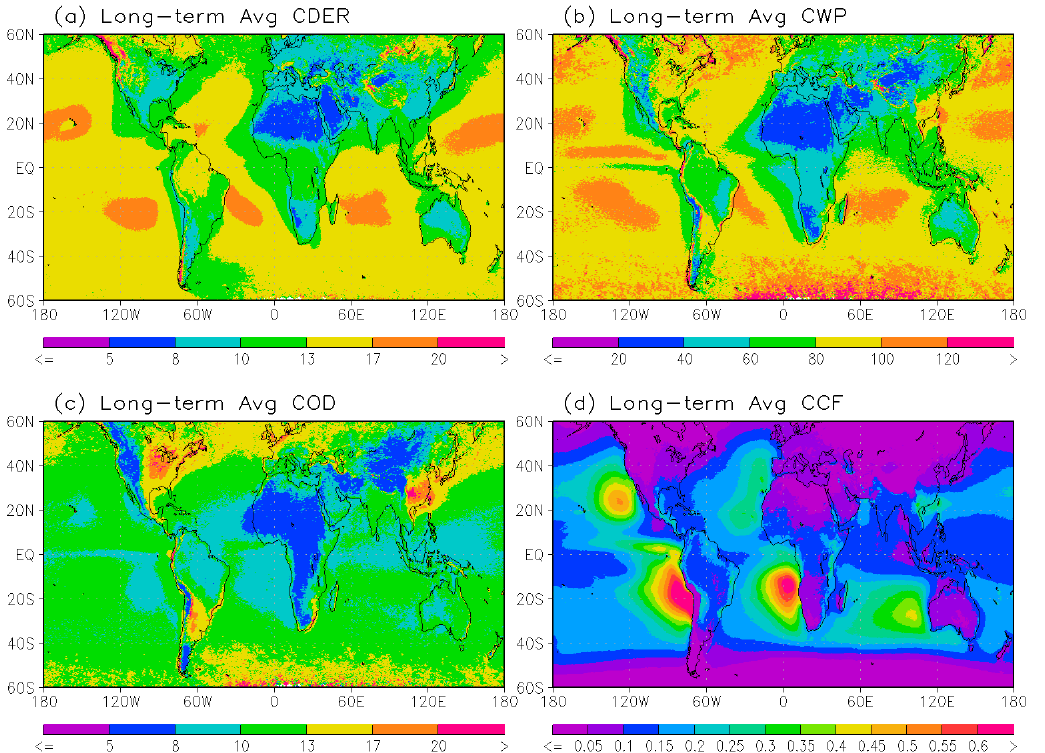
Figure 2. Global maps for long-term (1981–2011) averaged monthly mean: ( a ) cloud droplet effective radius (CDER); ( b ) cloud water path (CWP); ( c ) cloud optical depth (COD); and ( d ) cloud cover fraction (CCF) of water clouds.